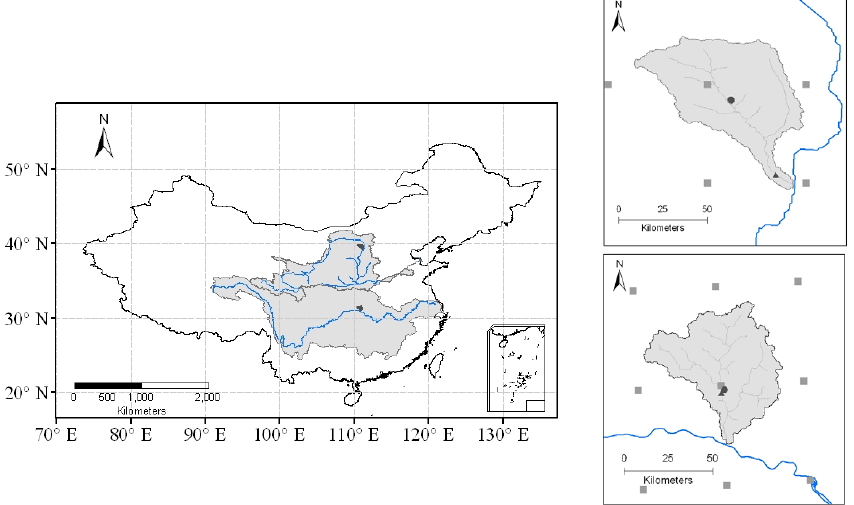
Fig. 1. Location of selected sub-catchments in the Yangtze and Yellow River Basins and climate stations (black circle), discharge stations (black triangle), and Climate Research Unit (CRU) grid nodes (grey square).